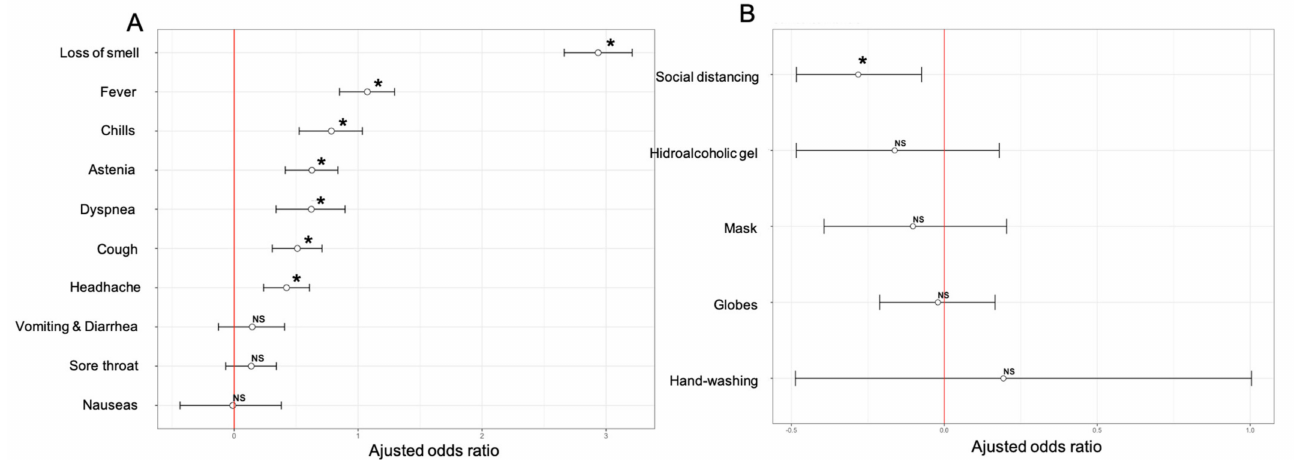
Figure 4. Adjusted odds-ratio and 95% confidence intervals for community exposure associated with main symptoms ( A ) and hygiene measures ( B ) with COVID-19. * p < 0.05. NS: Non-significant.